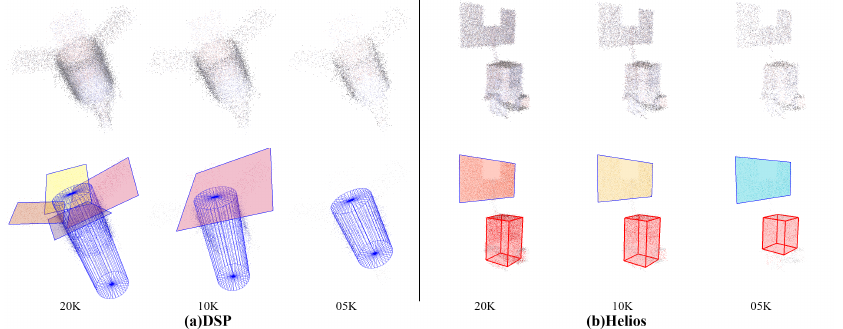
Figure 8. Results of robustness analysis with integrated factors. The left grid column is the detection results of spacecraft ( a ) DSP, and the right grid column is the results of ( b ) Helios. The top row in each grid displays the origin input point clouds, and the bottom row displays the final results. From left to right in each grid are point clouds with different sample numbers ( **K_04U_15D ). The cylinders are rendered in blue; cuboids are rendered as red boxes; and patches are rendered in different